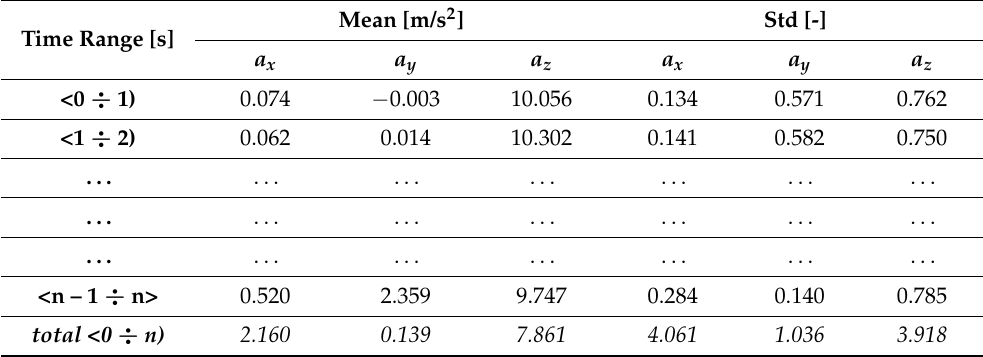
Table 1. Basic statistical measures of vibration waveforms in successive time intervals. Source: adapted from [2].